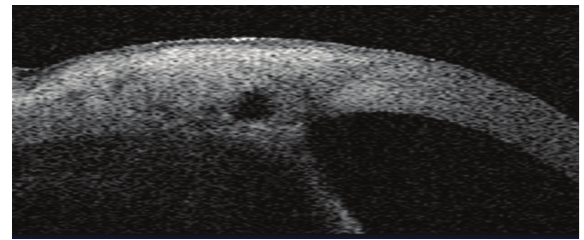
Figure 10: AS-OCT: non-functioning bleb after standard tra- beculectomy.